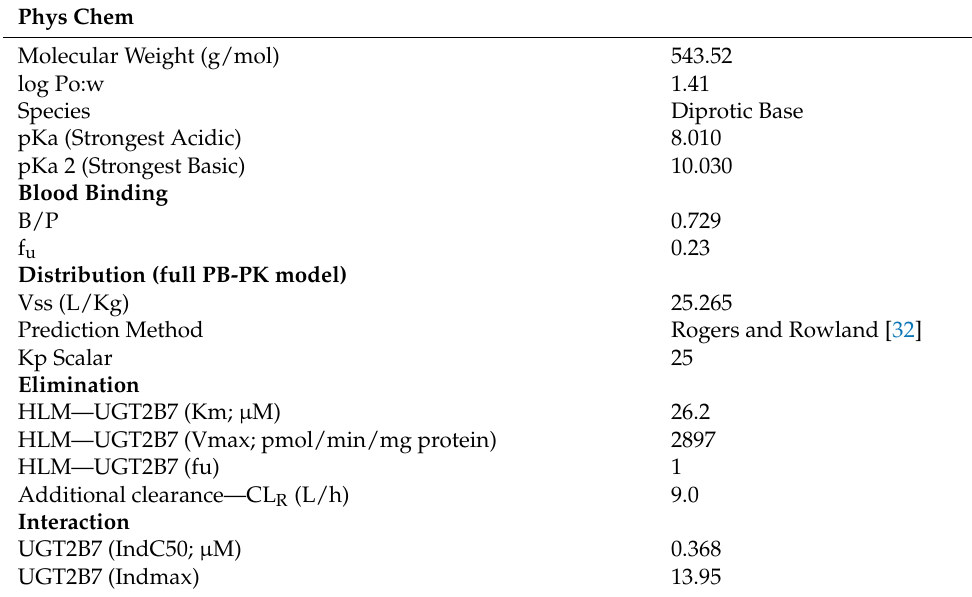
Table 2. Compound profile for epirubicin based on the physiochemical properties